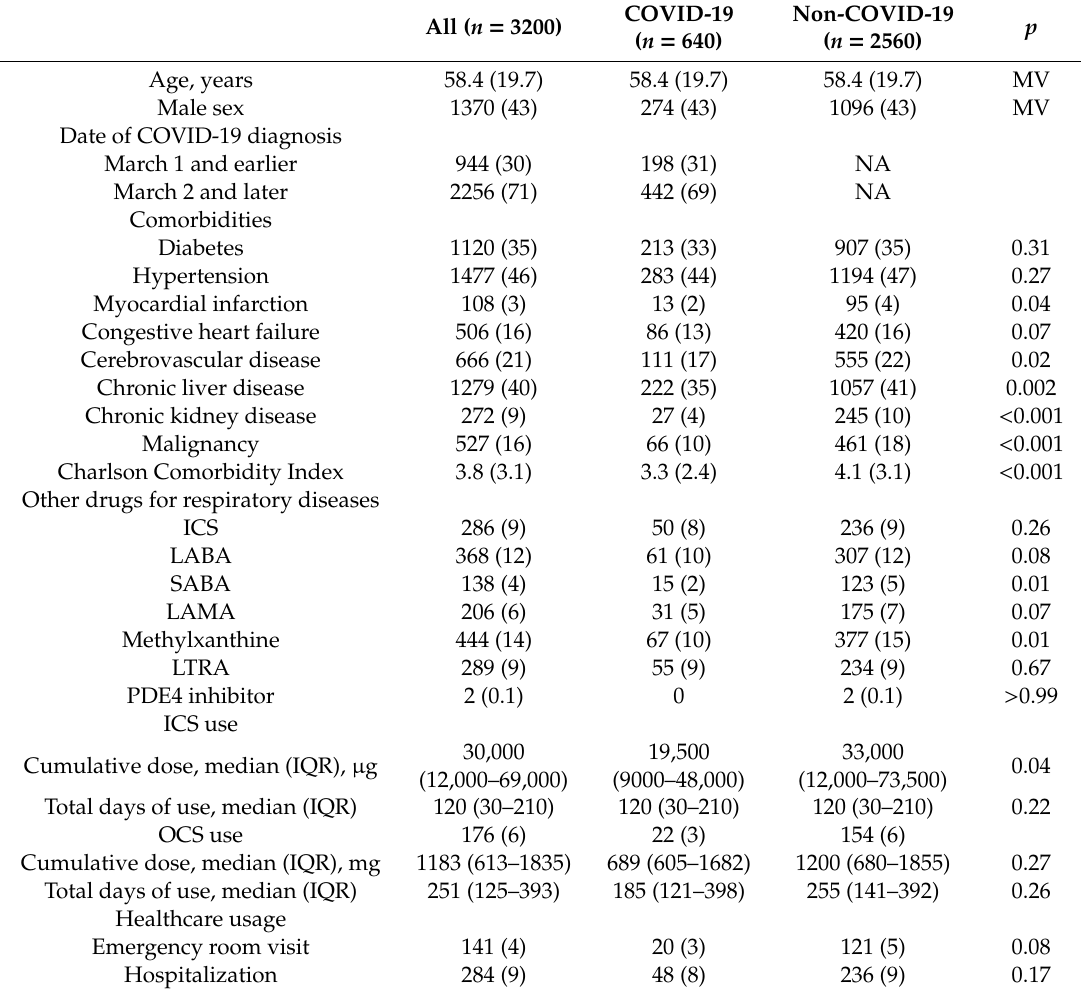
Table 3. Baseline characteristics of COPD patients with COVID-19 and matched